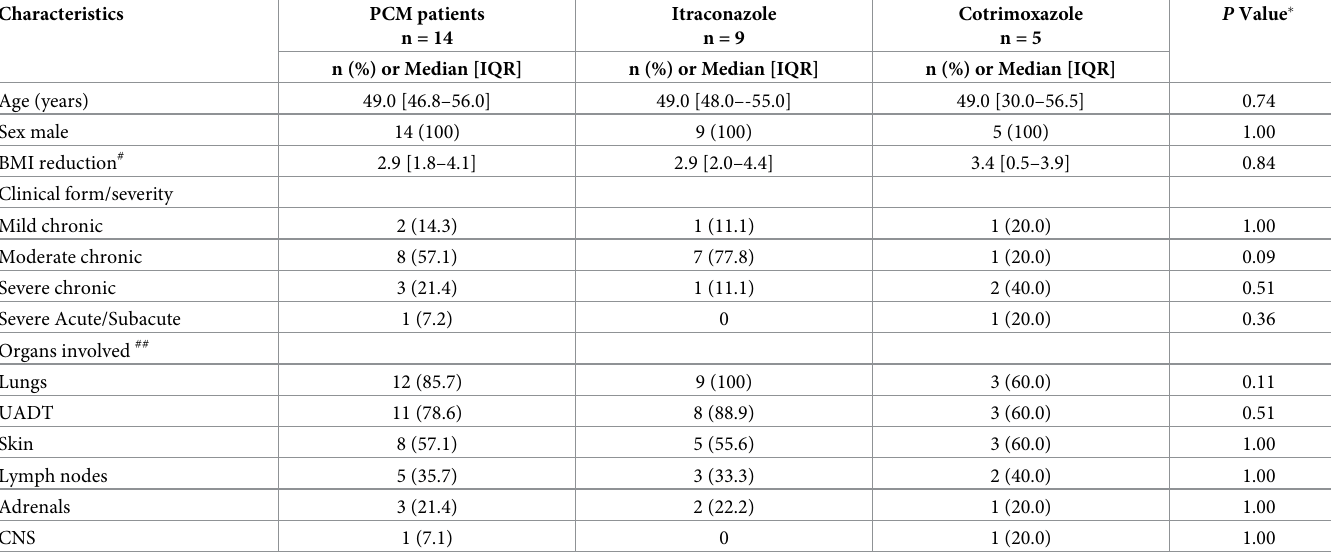
Table 1. Characteristics of 14 patients with paracoccidioidomycosis according to the antifungal compound used in their treatment.